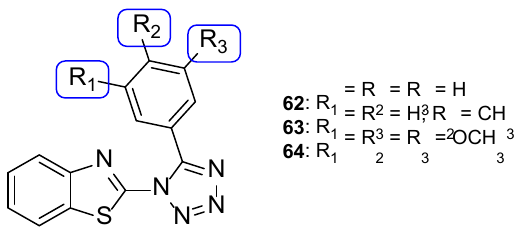
Figure 33. Chemical structures of compounds 62 – 64 [113]. Łukowska-Chojnacka et al. tested newly synthesized compounds with tetrazole and benzothiazole/benzoxazole moieties against C. albicans , A. niger , Colletotrichum coccodes , Fusarium sambucinum , and F. oxysporum , to determine their antifungal activities. All com- pounds presented little to no activity against all strains, except for C. albicans . Despite the